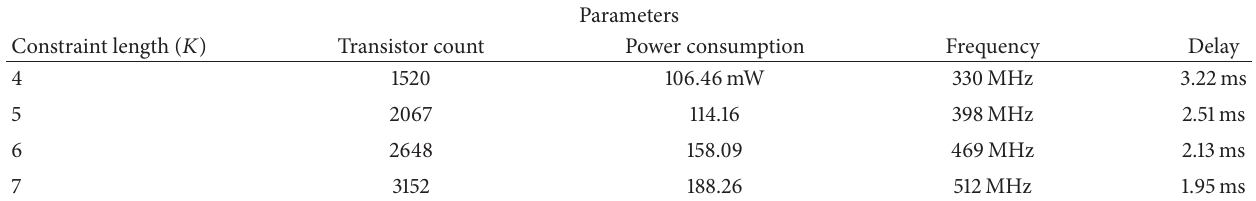
Table 1: Comparison of parameters of synchronous Viterbi decoder for various constraint lengths.